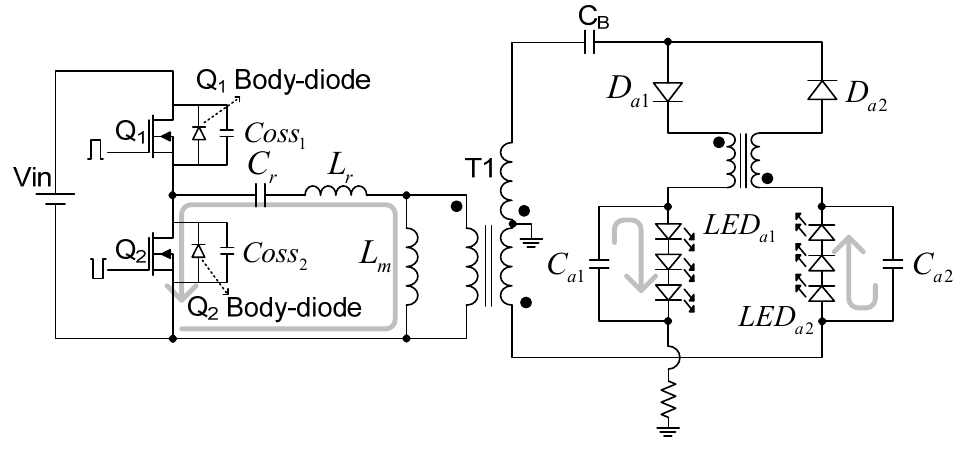
Figure 11. Circuit diagram during Mode